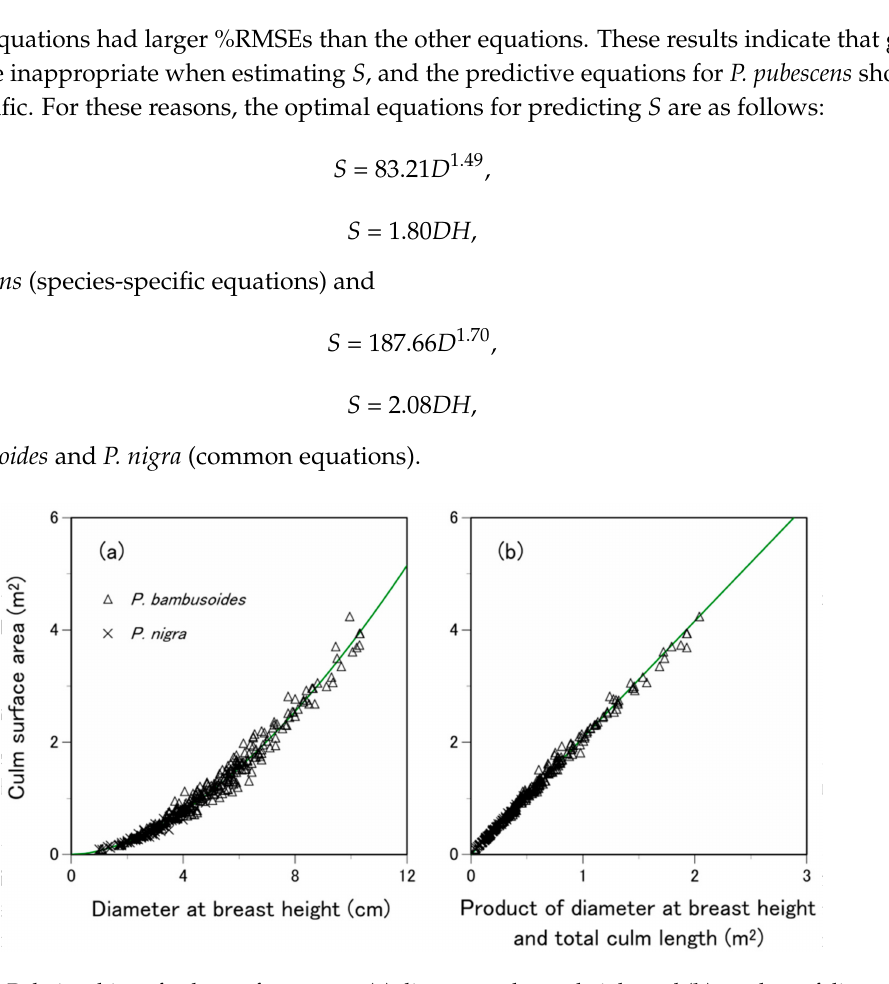
Figure 5. Relationships of culm surface area to ( a ) diameter at breast height and ( b ) product of diameter at breast height and total culm length for Phyllostachys bambusoides and P. nigra . The solid lines represent the power and linear equations detailed in Table 3.